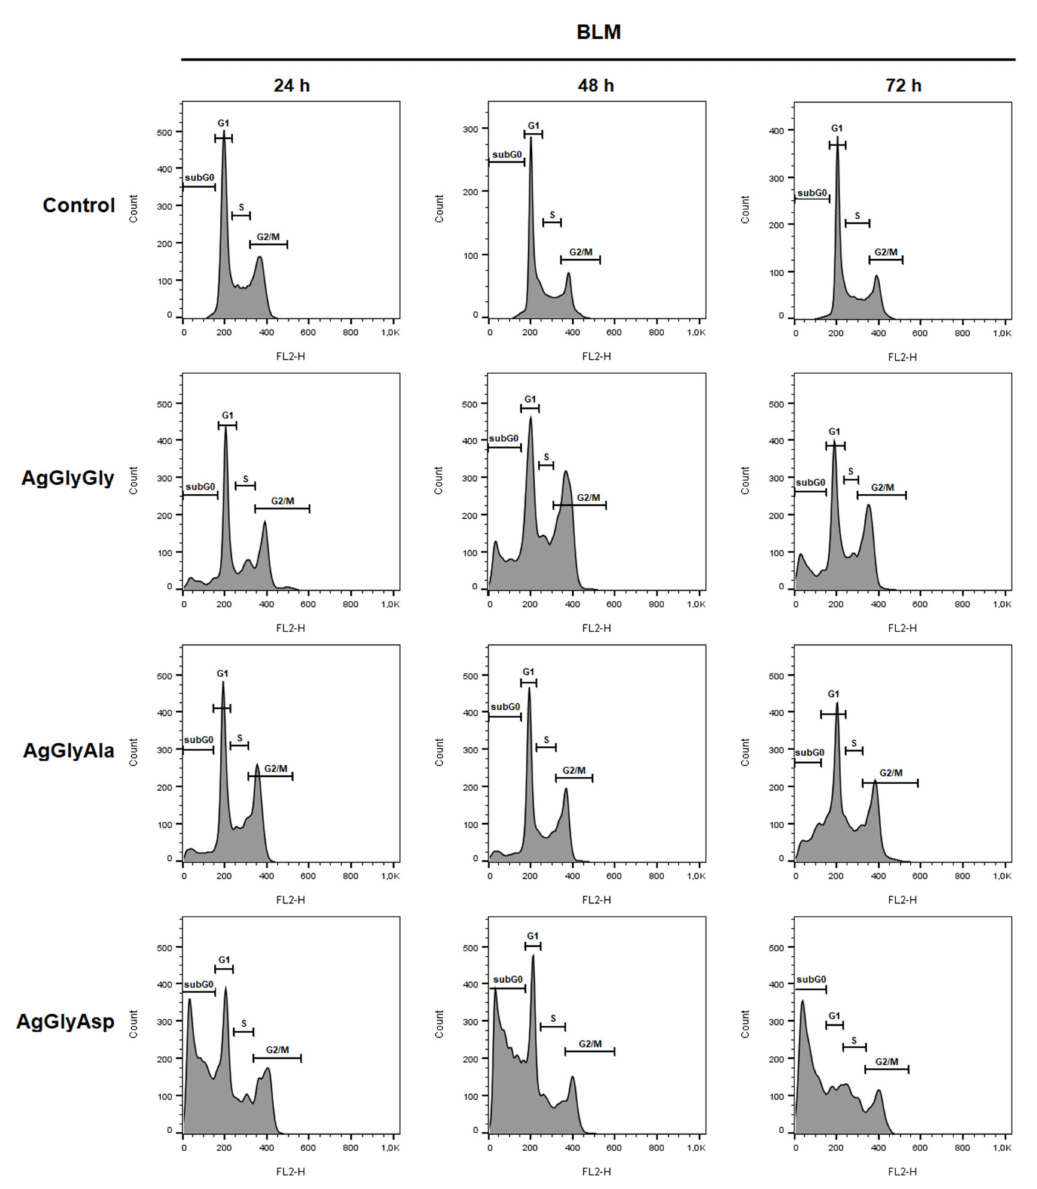
Figure 15. Histogram representation of cell cycle distribution in BLM cells treated with IC50 AgGlyGly, AgGlyAla and AgGlyAsp after 24 h, 48 h and 72 h. Representative data of three independent experiments are